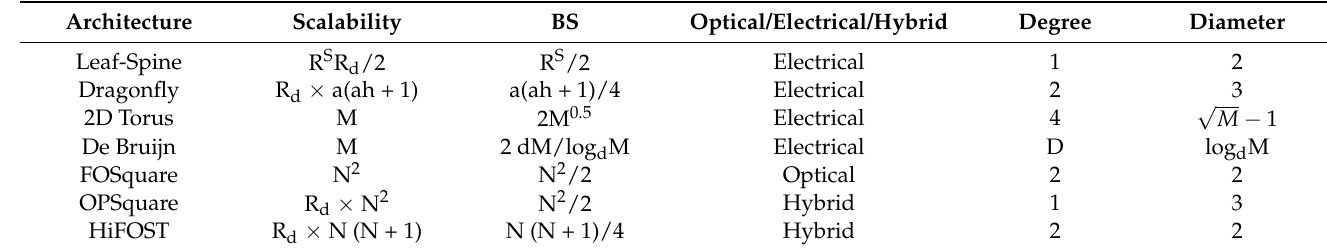
Table 1. Comparison of various network architecture (M: network size, R S : radix of inter-group (Spine) switch, R d : down link radix of intra-group (leaf) switch, a: local channels and h: global channels in Dragon, N: radix of fast optical switch. BS: Bisection